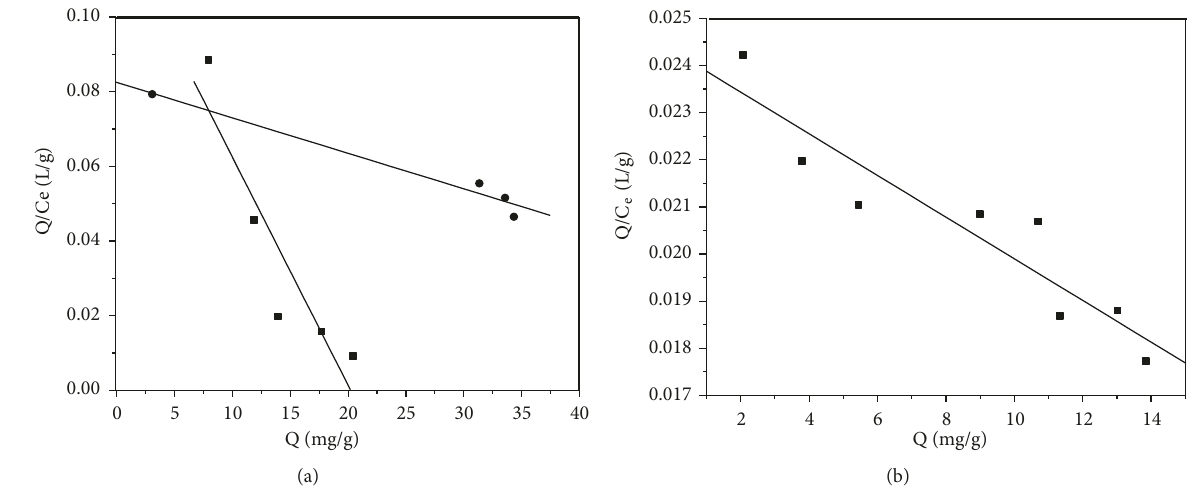
Figure 5: Scatchard analysis plot of the binding of ENR to the P GMA